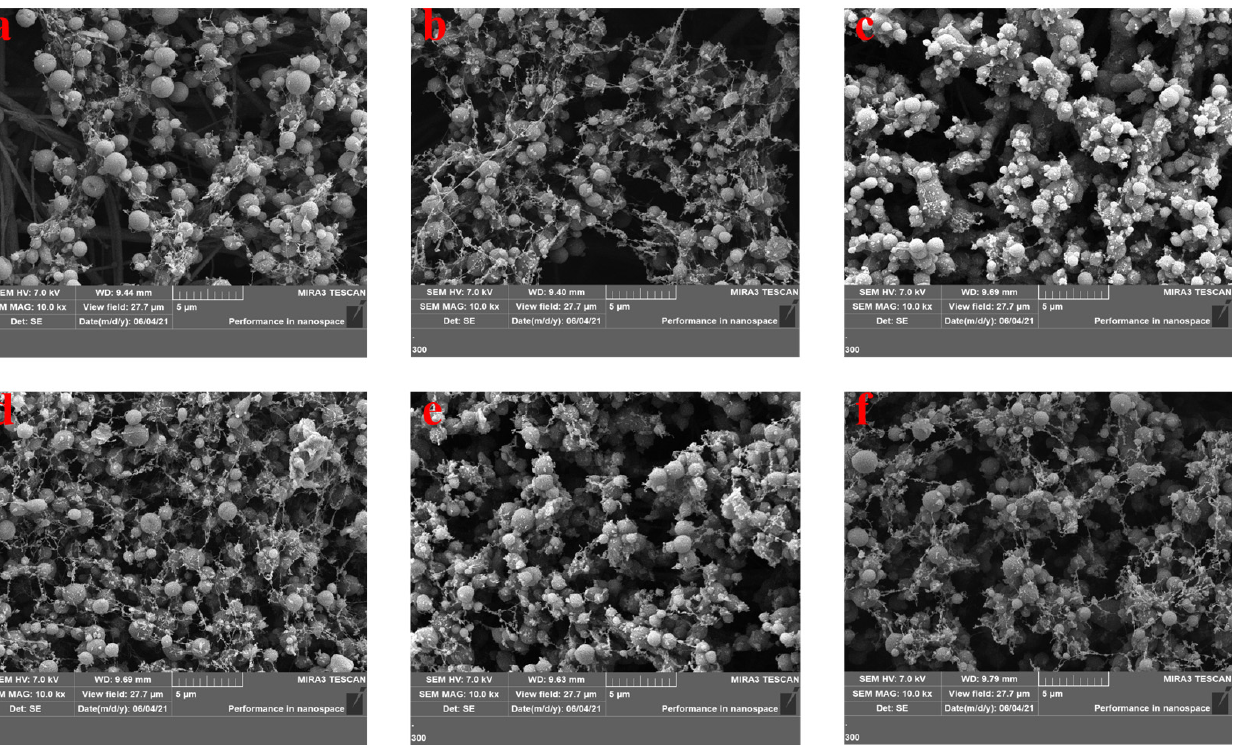
Figure 3. Scanning electron microscopy of flavonoids after sampling of the electrospinning film ( a ) Chrysin, ( b ) Baicalein, ( c ) Scutellarein, ( d ) Genistein, ( e ) Quercetin, ( f )